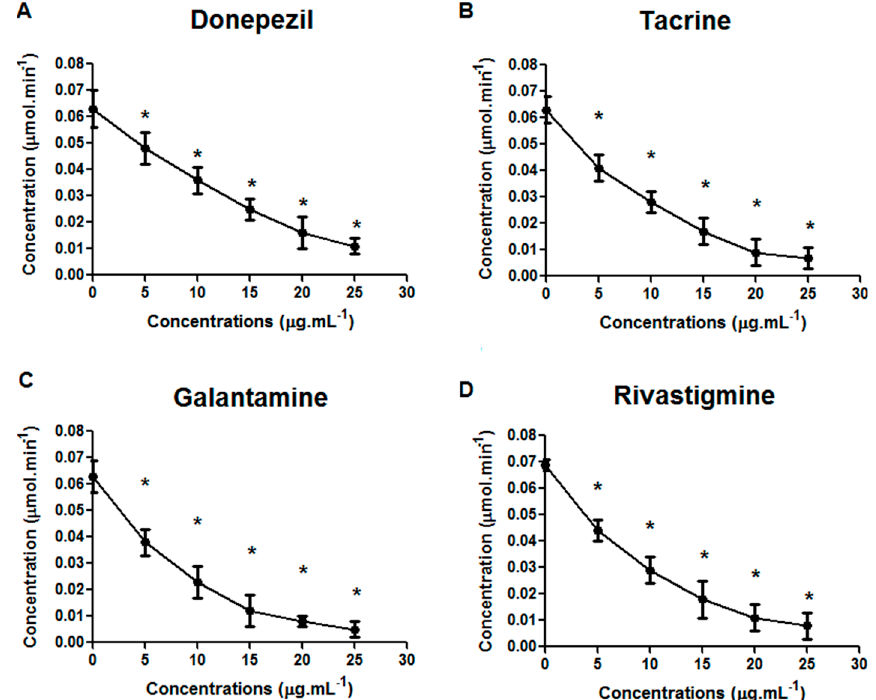
Figure 1. Effects of donepezil ( A ), tacrine ( B ); rivastigmine ( C ) and galantamine ( D ) on the inhibition of acetylcholinesterase in Dugesia tigrina , after 24 h of exposure. * Means differ by Dunnett’s test ( p = 0.05). n = 3–15 planarians per group.